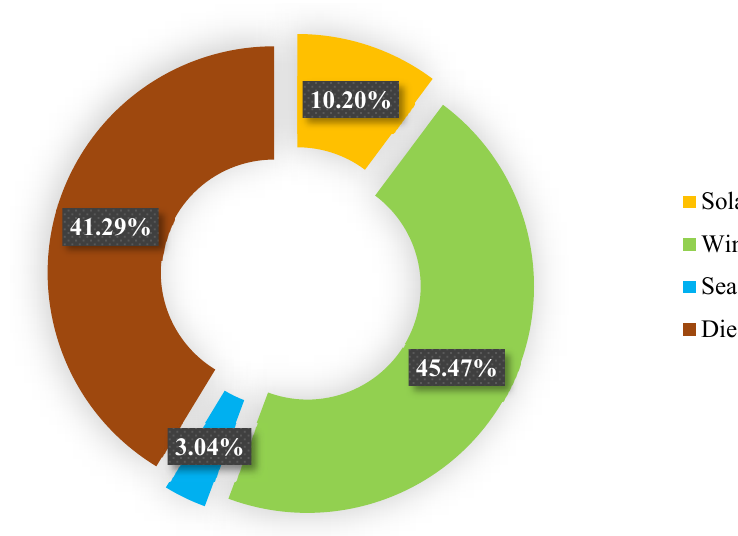
Figure 7. Share of each source in Aeolian Islands Energy Scenario.